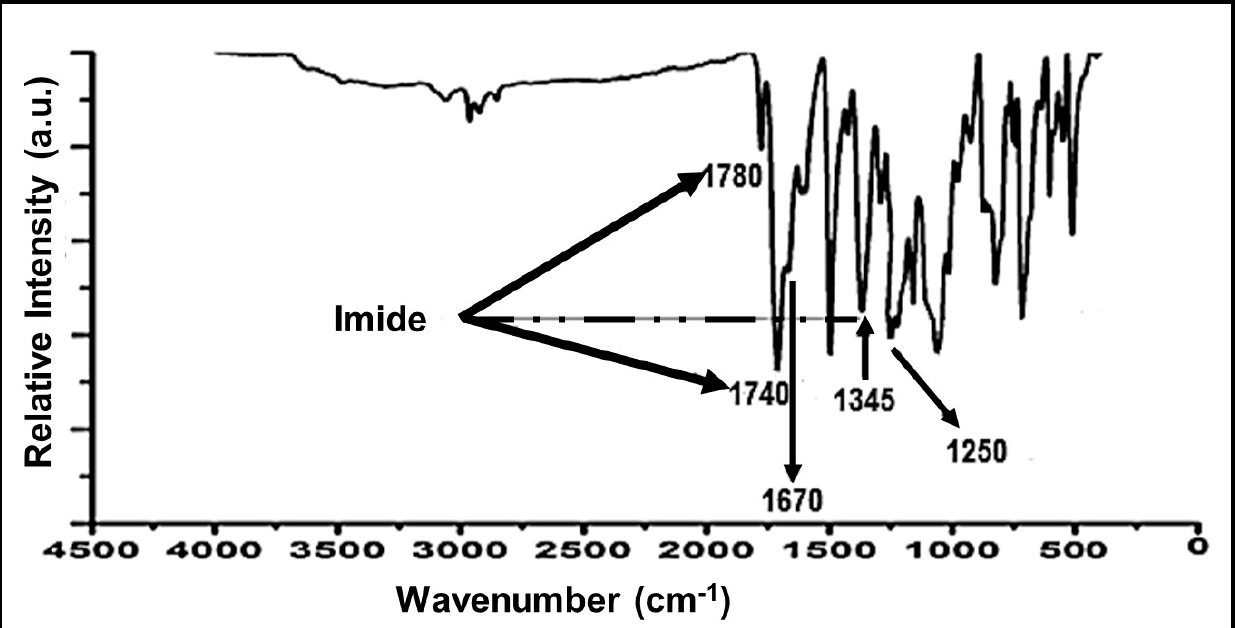
Figure 4. FTIR of a novel sulfonated polyimide (NSPI).